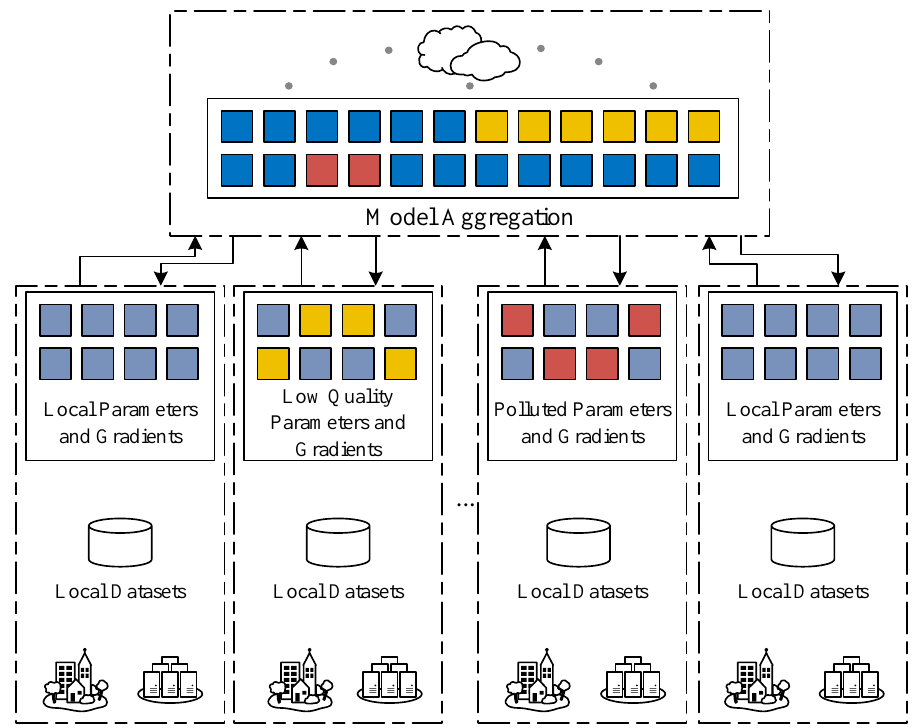
Figure 1. An example of a federated learning framework in IoT. Among them, the red squares represent the contaminated gradient parameters uploaded by malicious nodes; the yellow squares represent the low-quality gradient parameters obtained after training by participants with low-quality data; the blue squares represent normal gradient